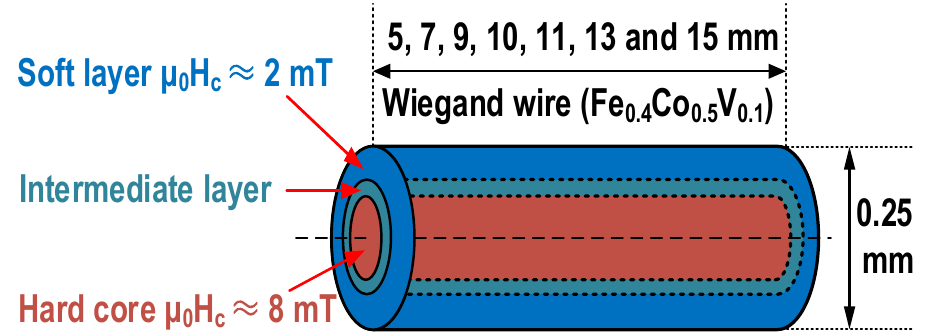
Figure 1. Schematic of magnetic structure and size of Wiegand wire.